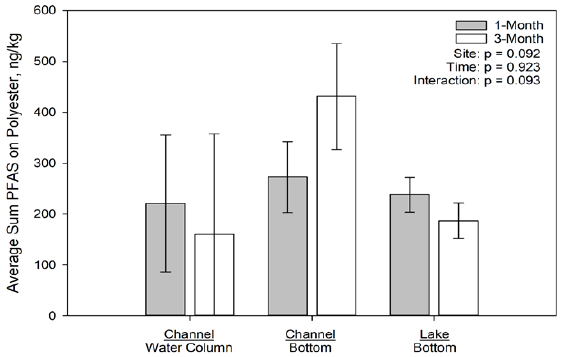
Figure 4. Average Sum of 7 PFAS (ng/kg) for Polypropylene Deployed in Muskegon Lake, MI. Asterisks indicate statistically significant differences between the 1 month vs. 3 month incubation at a specific site.